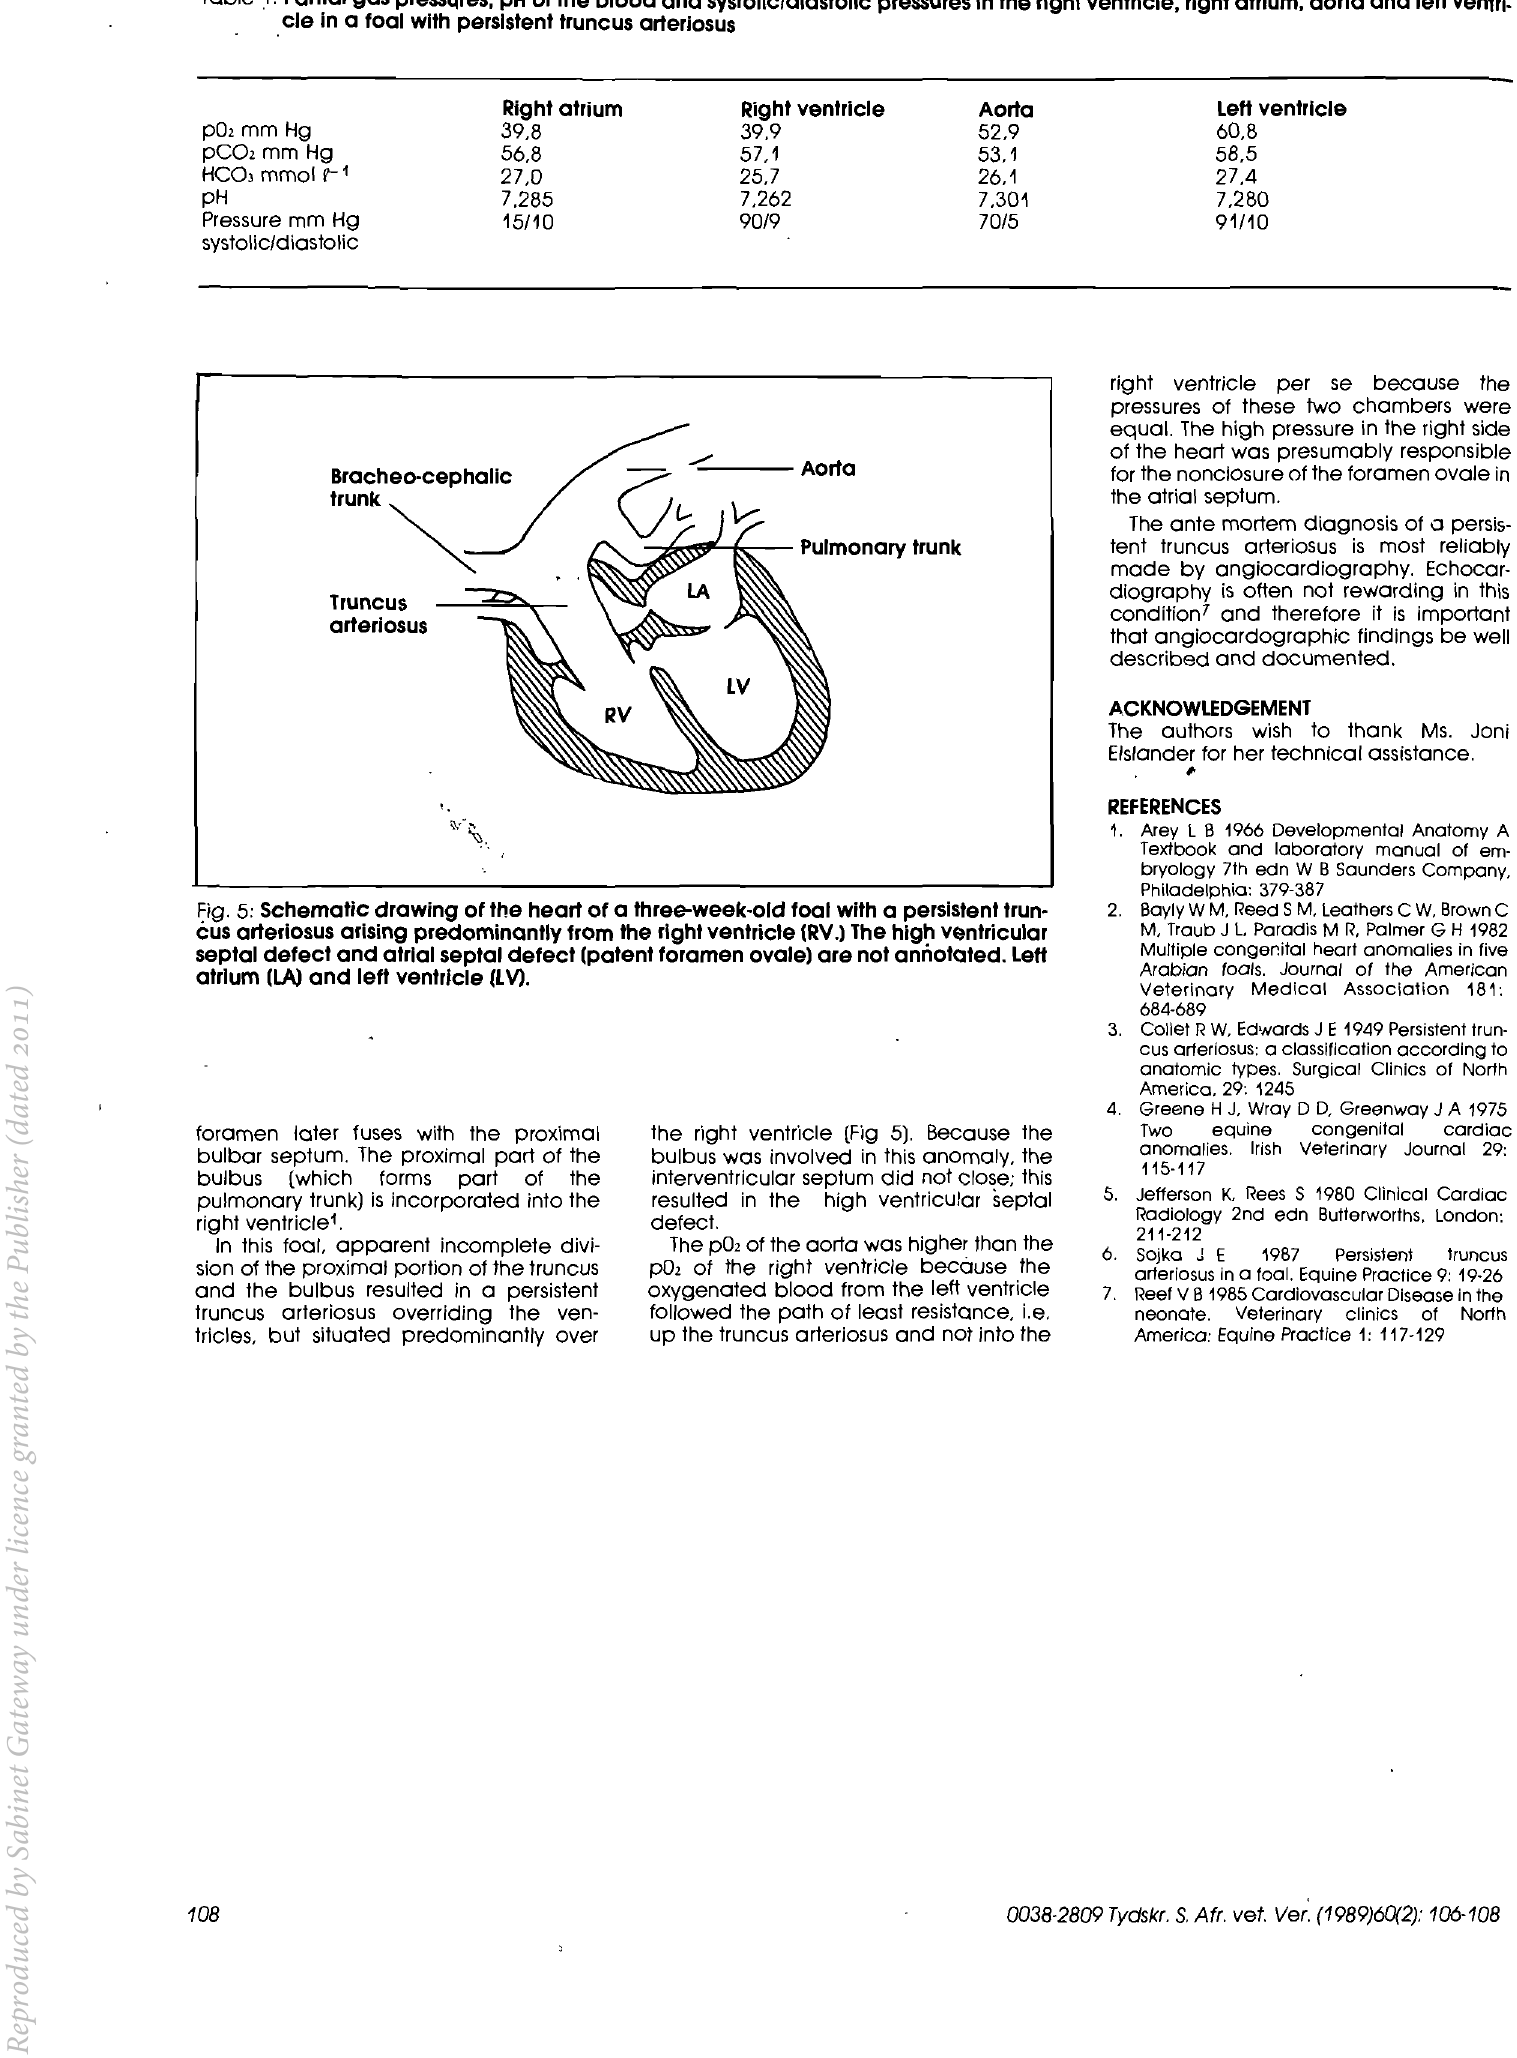
Table 1: Part!al gas press~res, j:lH of the blood and systolic/diastolic pressures in the right ventricle, right atrium, aorta and Ie" ventri- . . cle In a foal with persistent truncus arteriosus